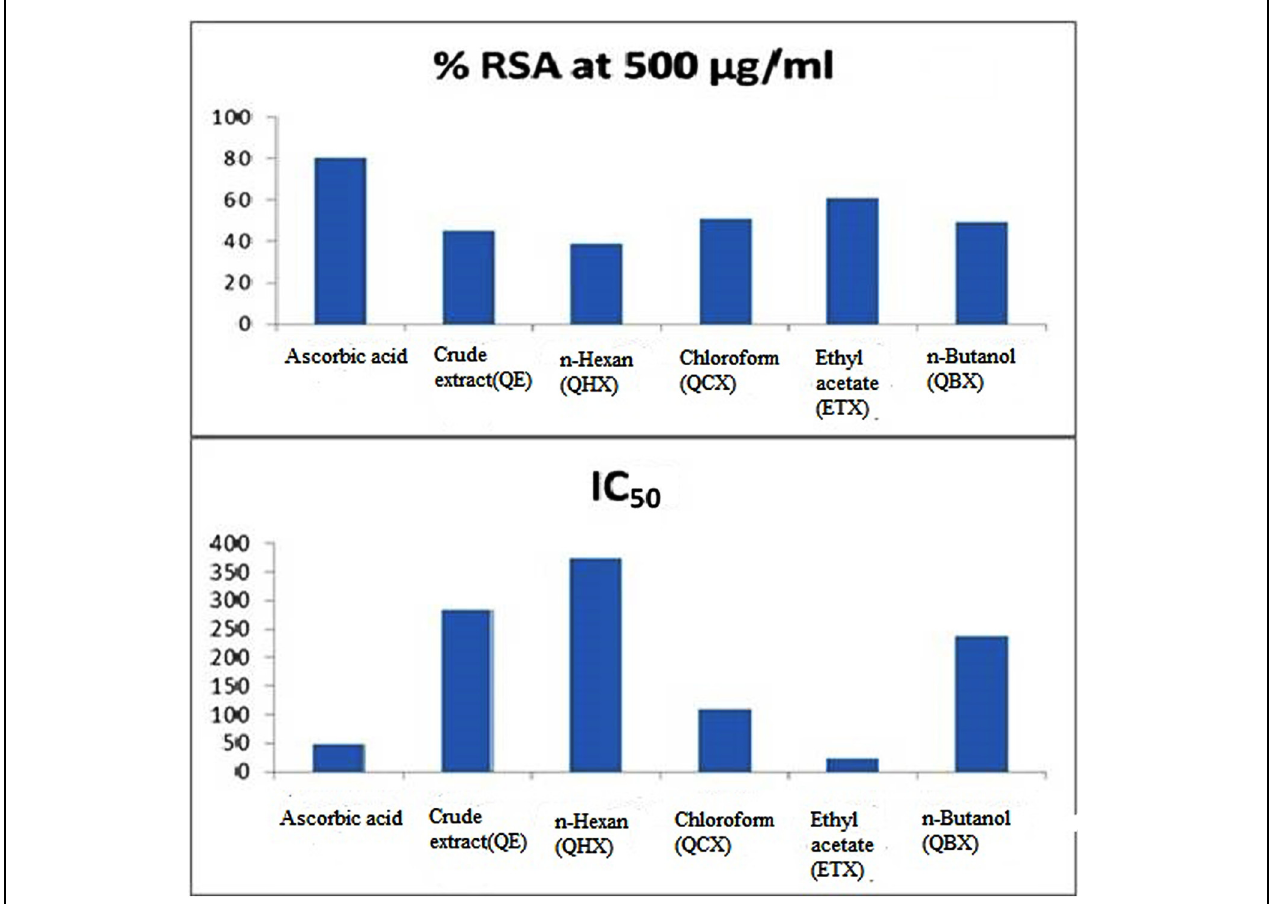
FIGURE 2 | NO activity in % RSA and IC 50